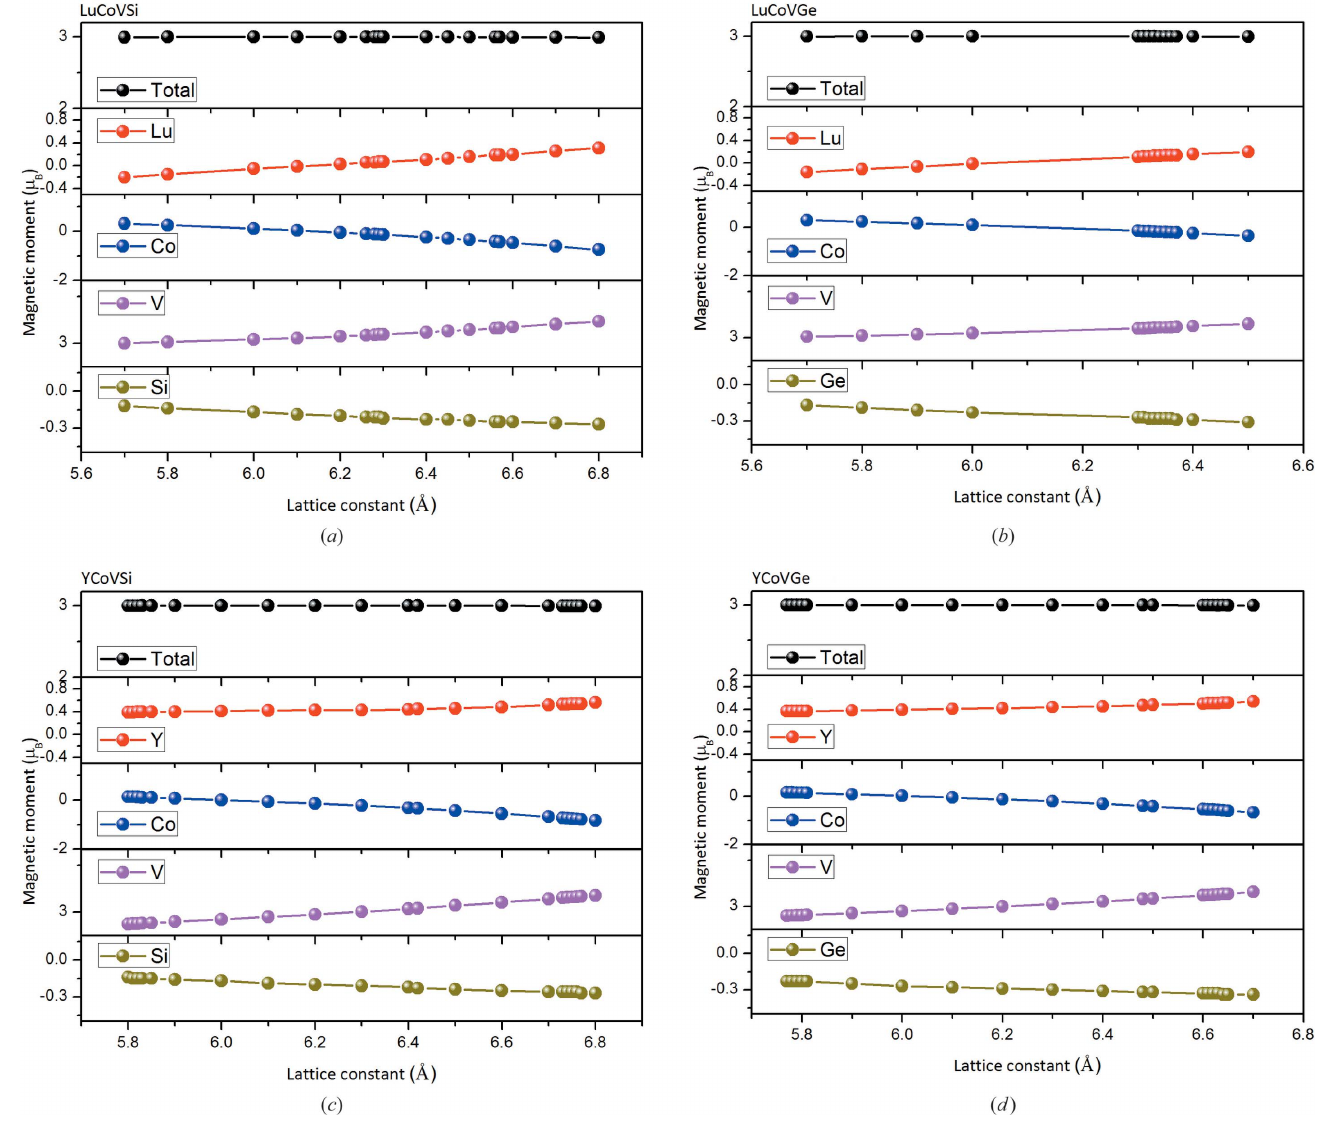
Figure 6 Total and individual atomic magnetic moments as functions of the lattice constants for ( a ) LuCoVSi, ( b ) LuCoVGe, ( c ) YCoVSi and ( d ) YCoVGe EQH